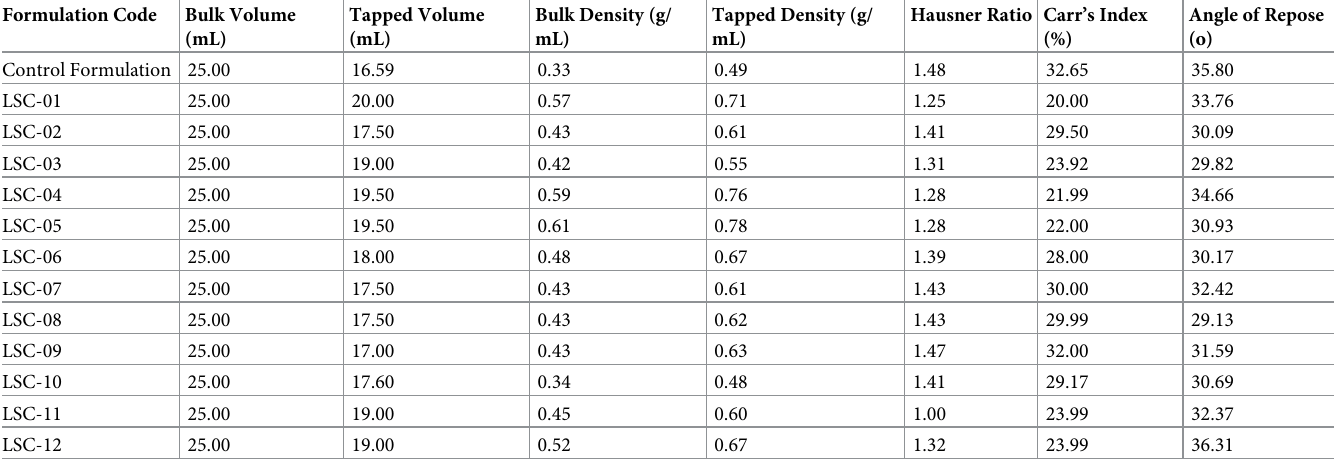
Table 4. Pre Compression evaluation of liquisolid compacts containing clopidogrel.